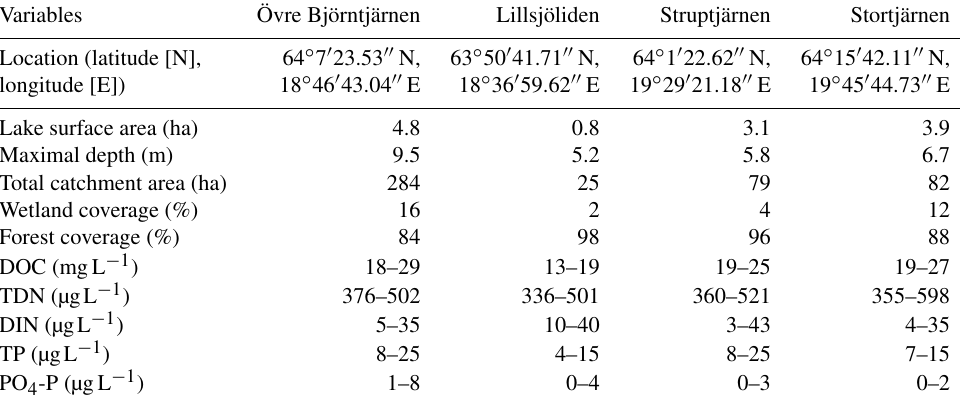
Table 1. Descriptive lake data and concentrations of total dissolved nitrogen (TDN), dissolved inorganic nitrogen (DIN), total phosphorus (TP), phosphate (PO 4 -P), and dissolved organic carbon (DOC) given as minimum and maximum values observed during the experimental period. Variables Övre Björntjärnen Lillsjöliden Struptjärnen